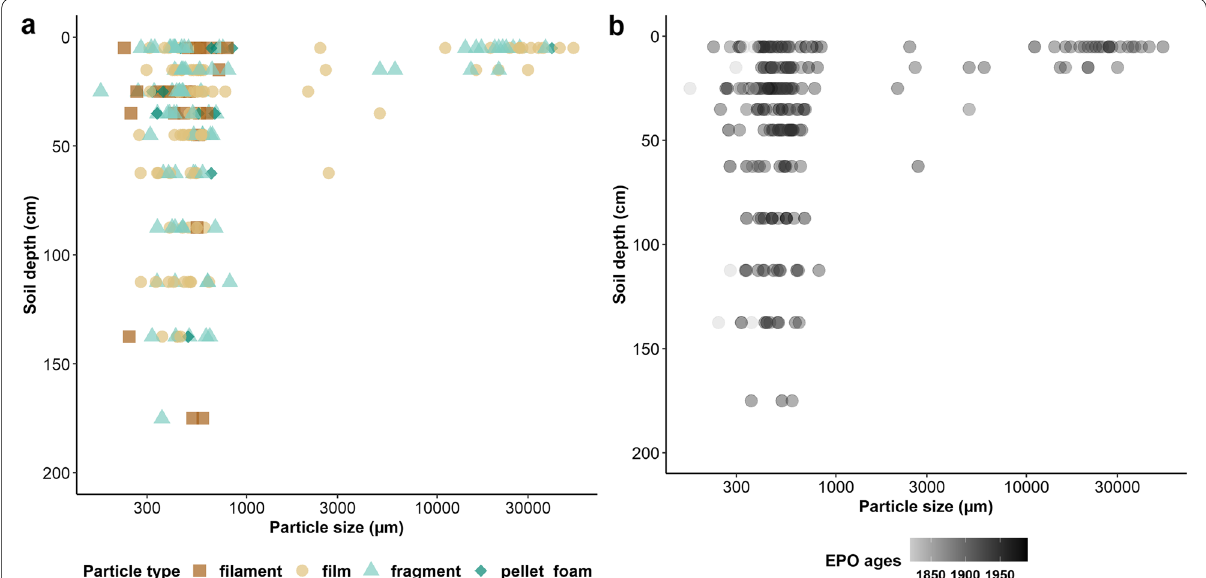
Fig. 6 Depth distribution of plastic particle sizes classified according to a particle type and b age of possible earliest occurrence (EPO ages) for whole particle size